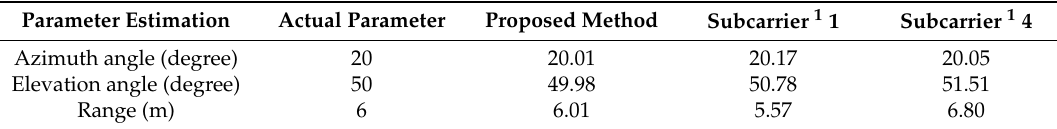
Table 2. 3-D parameter estimation comparison.